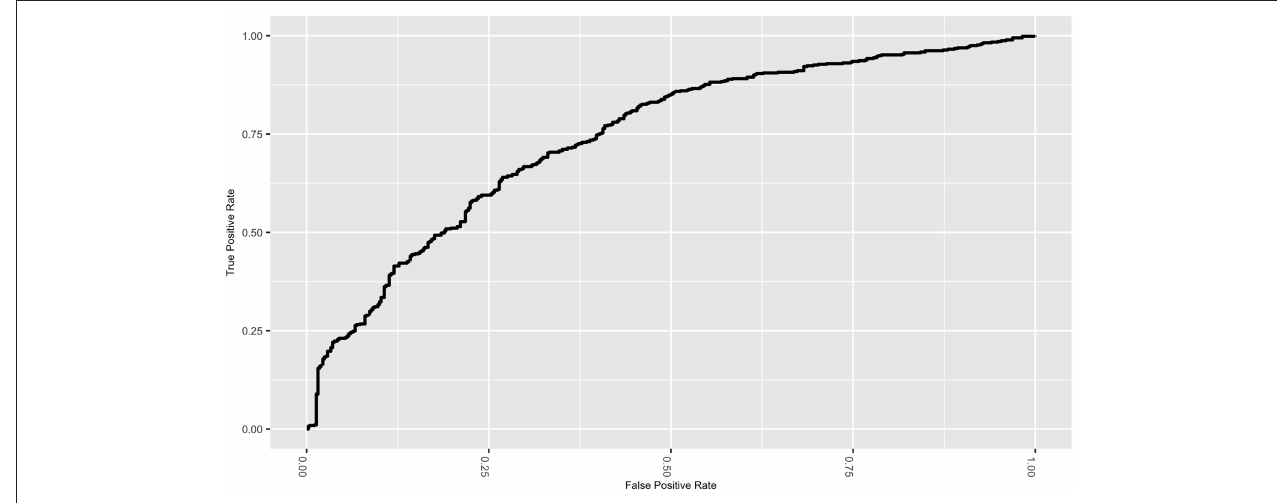
FIGURE 4 | ROC curve for the elastic net classifier with the linear combinations